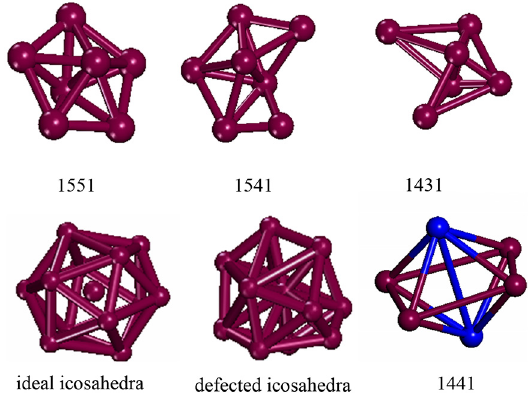
Figure 4. Three-dimensional structures for some typical bonded